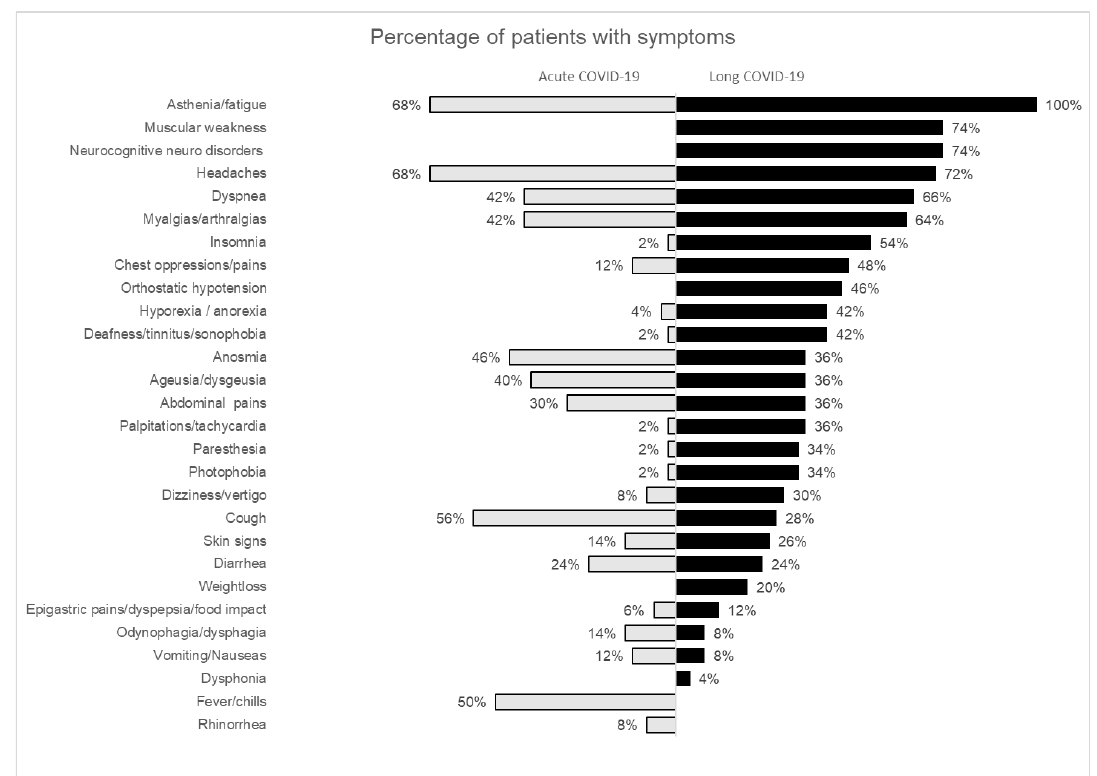
Figure 1. Percentage of patients with symptoms in both acute and long COVID phases. The figure shows percentages of patients presenting with specific COVID-19-related symptoms during the acute phase of the disease ( left ) and the post-COVID-19 phase ( right ). Abbreviations: COVID-19, coronavirus disease 2019.